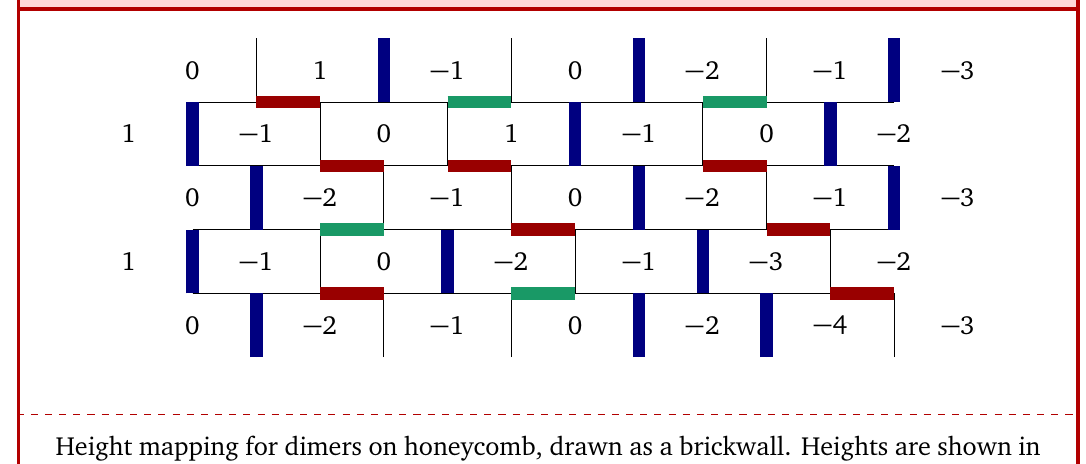
Figure 12: Height mapping for dimers on the honeycomb lattice